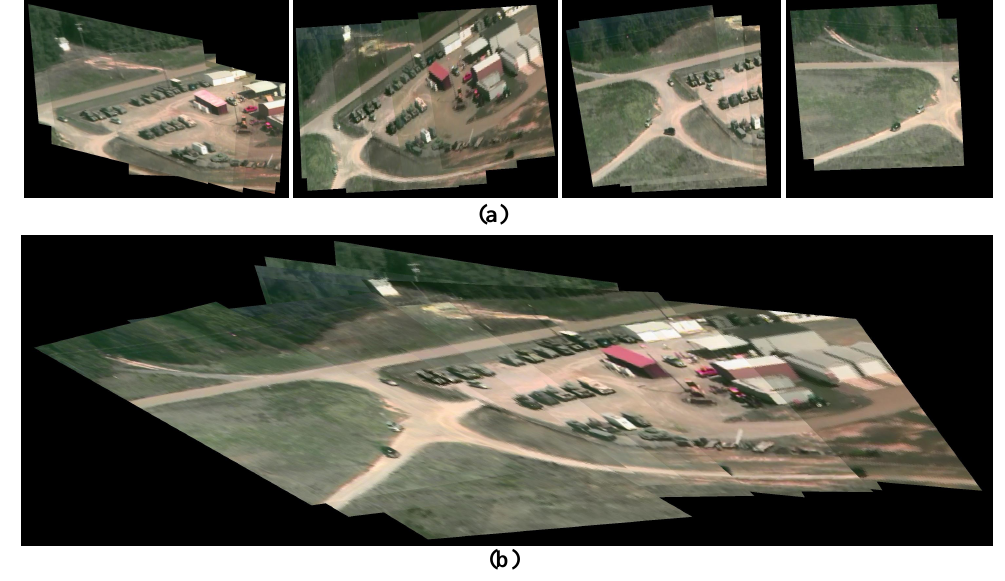
Figure 3. Example of sequential stitching vs . hybrid stitching. ( a ) Sequential stitching results over time with 4 panorama patches from 1 scene. ( b ) Our hybrid stitching result with a complete scene